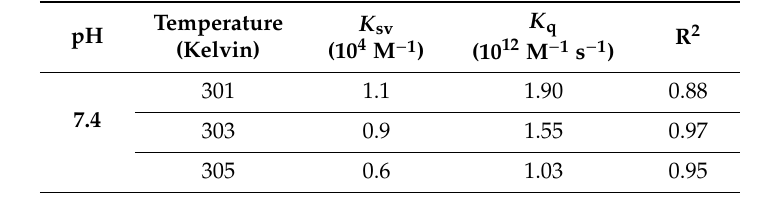
Table 1. Thermodynamic parameters of Rivastigmine tartrate (RT)–human transferrin (hTf) system as calculated from fluorescence spectroscopy quenching experiments.